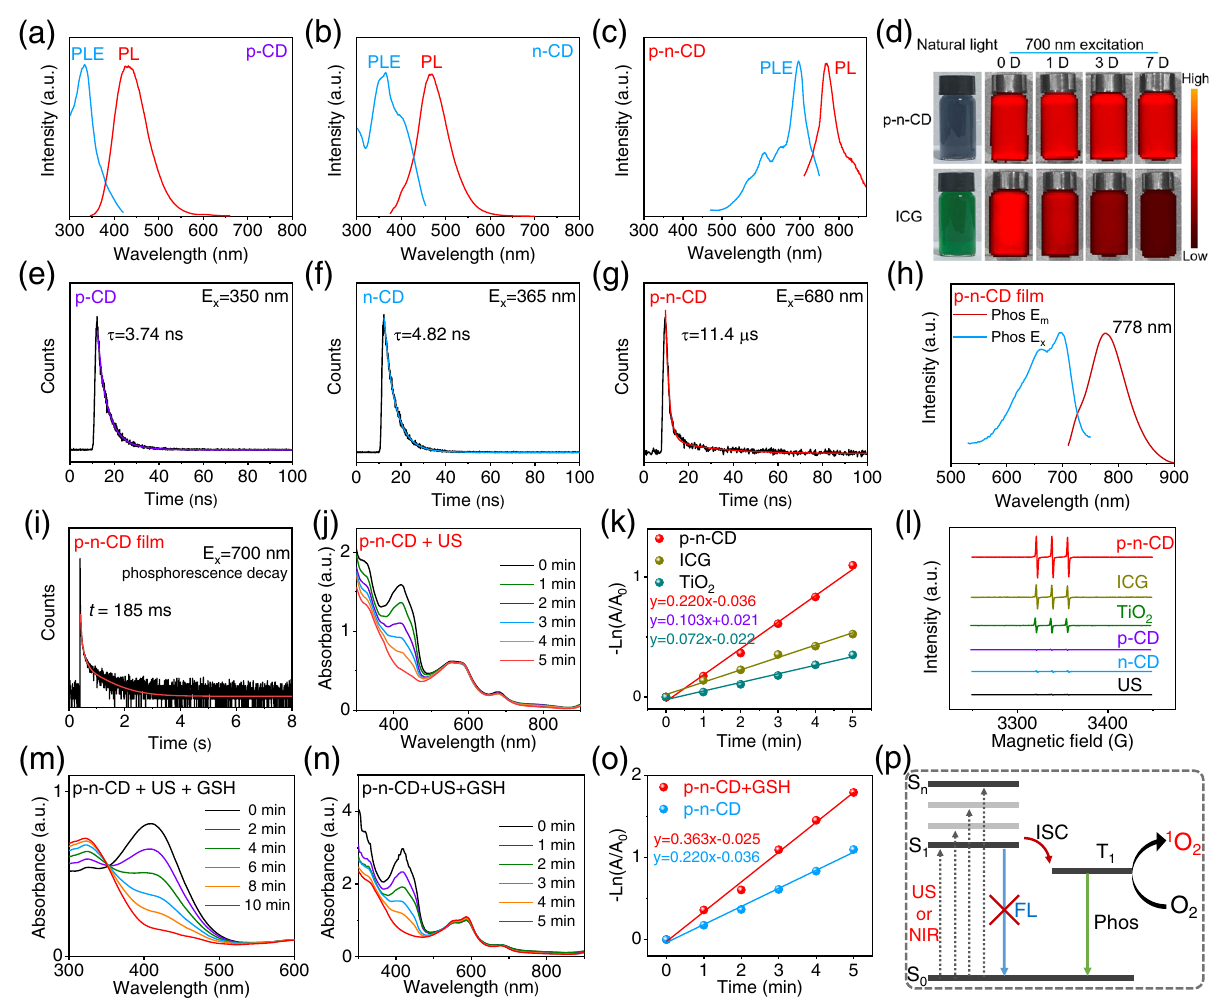
Fig. 4 | NIR phosphorescence, sonodynamic and GSH depletion properties of p – n-CDs. a – c PL and excitation (PLE) spectraof p-CDs ( a ),n-CDs ( b ),and p – n-CDs ( c ). d NIRemittingstabilitycontrastbetweenp – n-CDsandICGinaqueoussolutions stored for 0, 1, 3, and 7 days. The excitation and emission wavelengths were 700 and 790nm, respectively. e – g Time-resolved PL spectra and the corresponding fi tting curves of p-CDs ( e ), n-CDs ( f ), and p – n-CDs ( g ). h Phosphorescence excita- tionandemissionspectraofp – n-CD@PVA fi lms. i Time-resolvedphosphorescence spectrum and the corresponding fi tting curve of p – n-CD@PVA. j Time-dependent 1 O 2 generation of p – n-CDs under US irradiation (50kHz, 3.0W/cm 2 ) for 5min detectedwiththeDPBFprobe. k RateconstantofUStriggered 1 O 2